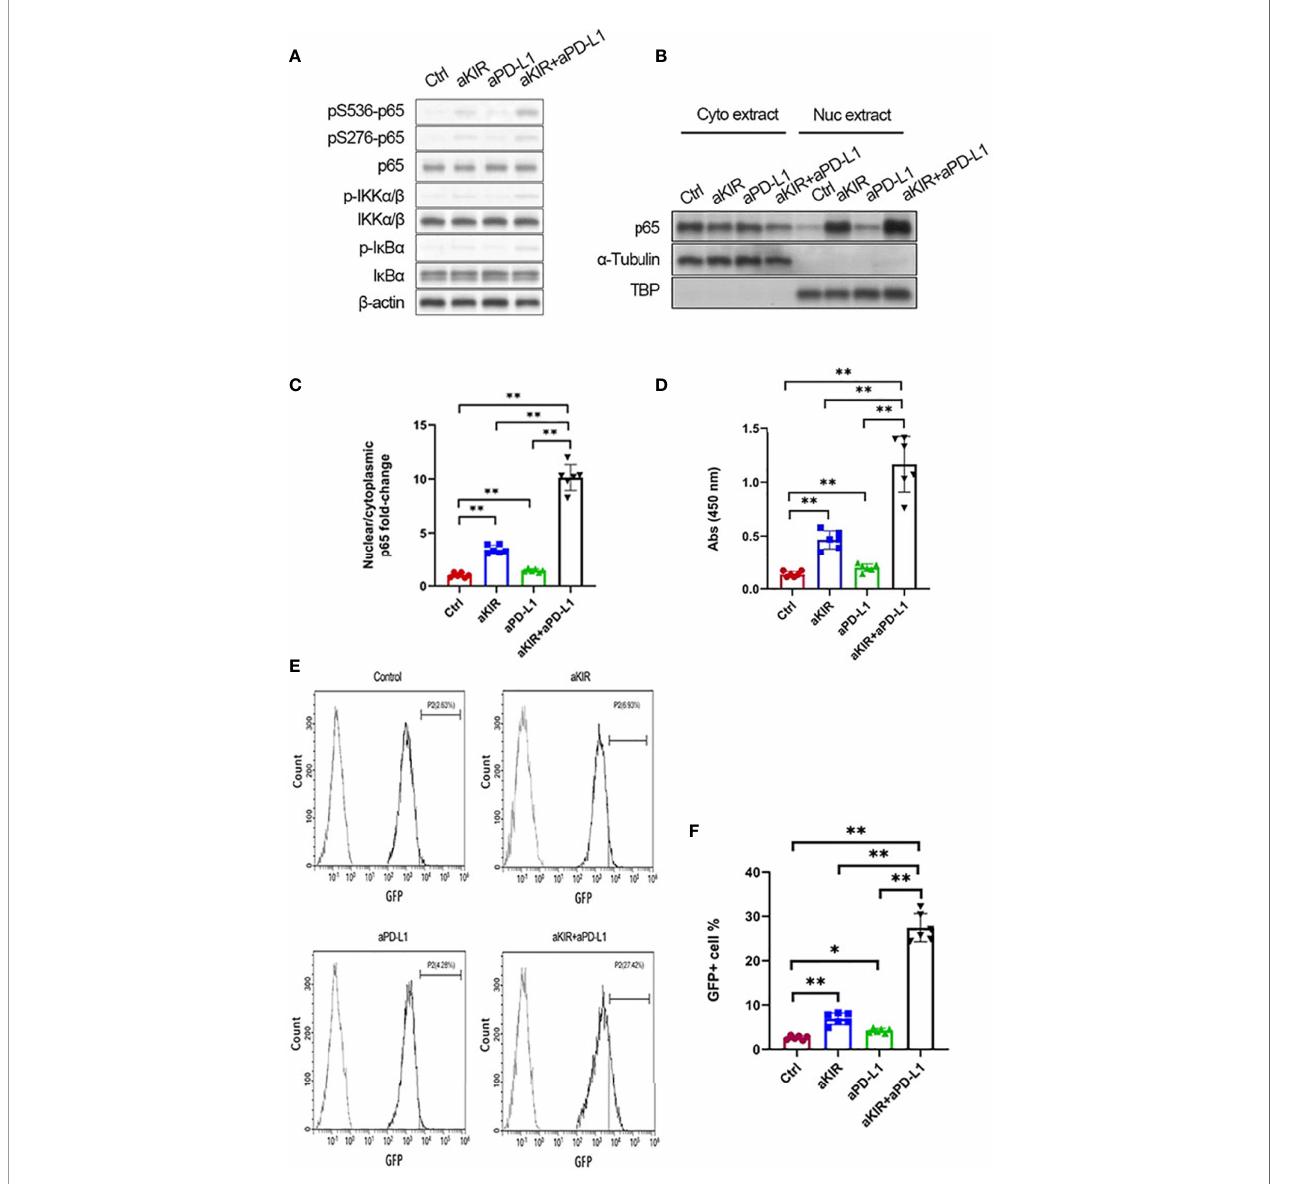
FIGURE 3 | Lirilumab and Avelumab Co-Engagement Disinhibits NF- k B. (A) IL-2-primed NK cells were mixed with autologous target cells and stimulated with lirilumab (aKIR) and/or avelumab (aPD-L1) by receptor crosslinking for 4 h. Whole cell lysates were immunoblotted for phospho-S536 p65, phospho-S276 p65, total p65, phospho-S176/180 IKK a / b , total IKK a / b , phospho-I k B a , total I k B a , and b -actin. (B, C) IL-2-primed NK cells were mixed with autologous target cells and stimulated with plate-immobilized aKIR and/or aPD-L1 for 1 h. Cytoplasmic and nuclear extracts were immunoblotted with anti-p65 antibody. The ratios of normalized nuclear p65:normalized cytoplasmic p65 are reported. (D) Nuclear extracts collected as in (B) were added to a 96-well plate immobilized with the consensus NF-kB-binding sequence. p65 bound to the oligonucleotide was measured by colorimetric assay. (E, F) IL-2-primed NK cells transduced with a k B-GFP reporter construct were mixed with autologous target cells and stimulated with plate-immobilized aKIR and/or aPD-L1 for 6 h. GFP expression in NK- k B-GFP cells was analyzed by fl ow cytometry. * P < 0.05, ** P < 0.01 [one-way ANOVA]. n= 3 biological replicates×3 technical